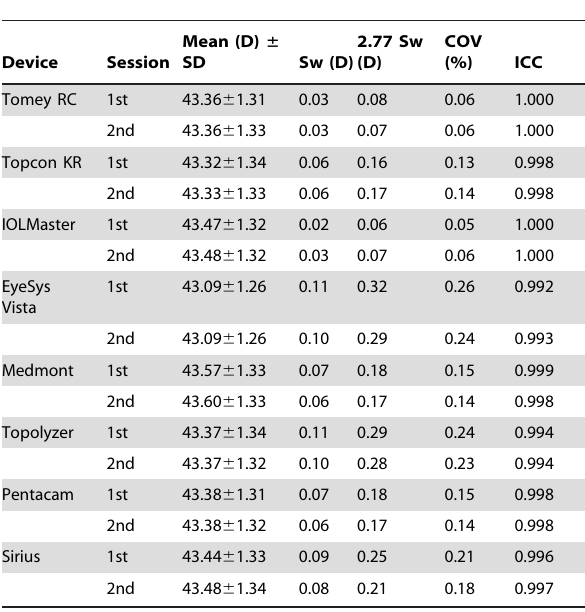
Table 3. Intrasession Repeatability of 8 Different Devices in Measuring Mean Keratometry (N